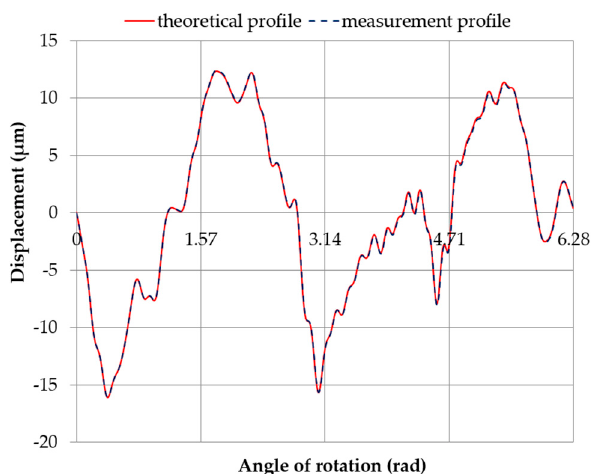
Figure 24. Measured and theoretical profiles (excluding harmonic component no. 1) obtained by superimposing the measured roundness profile of journal no. 5 onto the full eccentric movement profile of the center of the measured roundness profile.